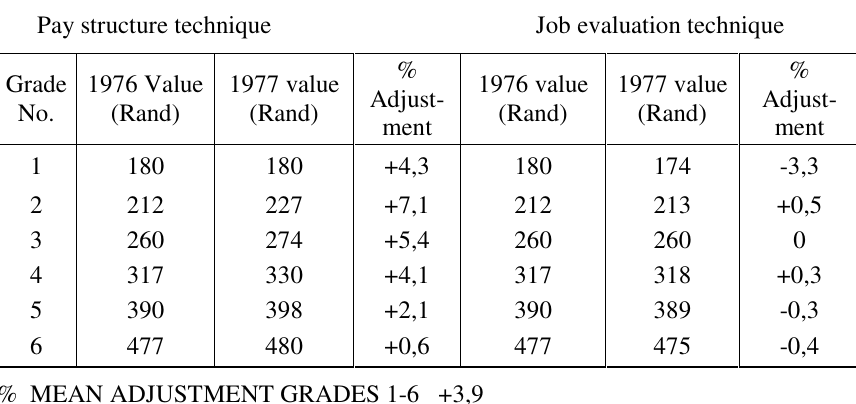
COMPARISON OF ADJUSTMENTS TO MARKET WAGE CURVE VALUES 1976 - 1977 Pay structure technique Job evaluation